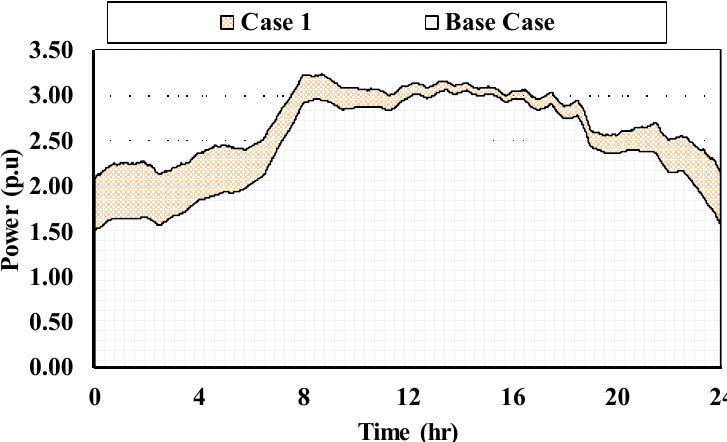
Figure 10. Total demand with uncontrolled EVs charging Case1.